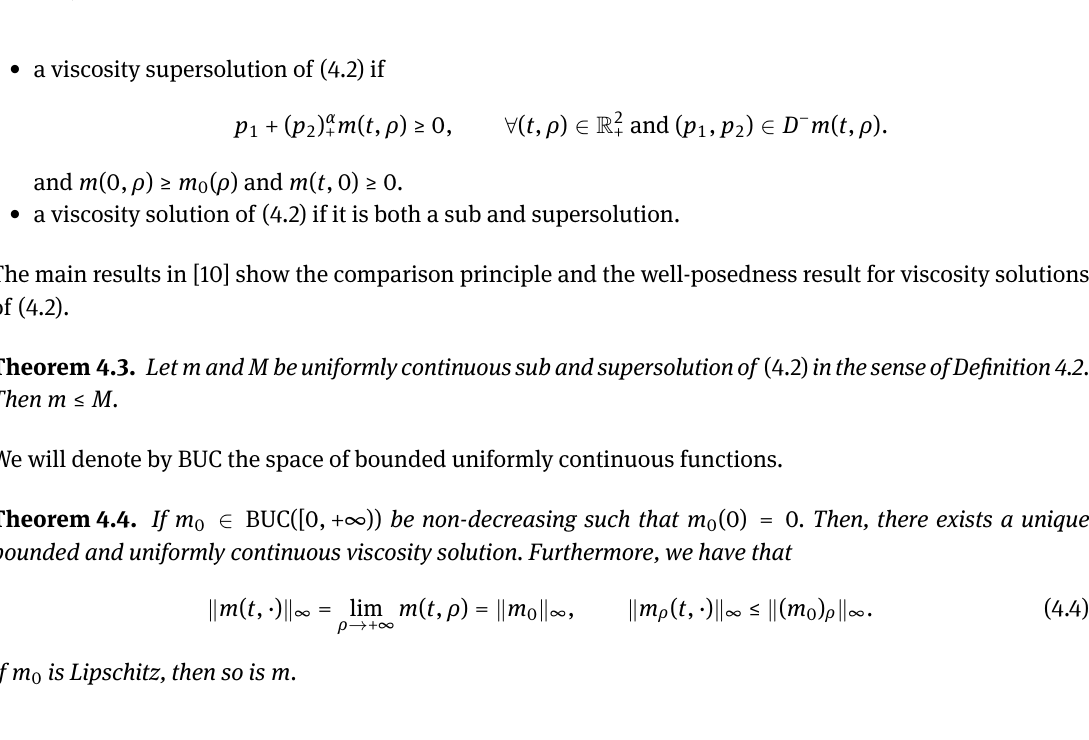
Fig. 3: Representation of (4.5) where c 0 = L =